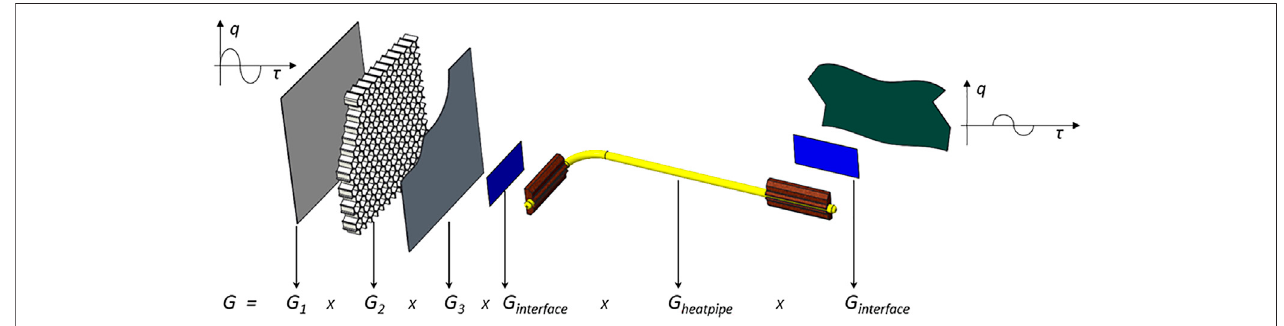
FIGURE 5 | Transfer function matrix along the heat transfer